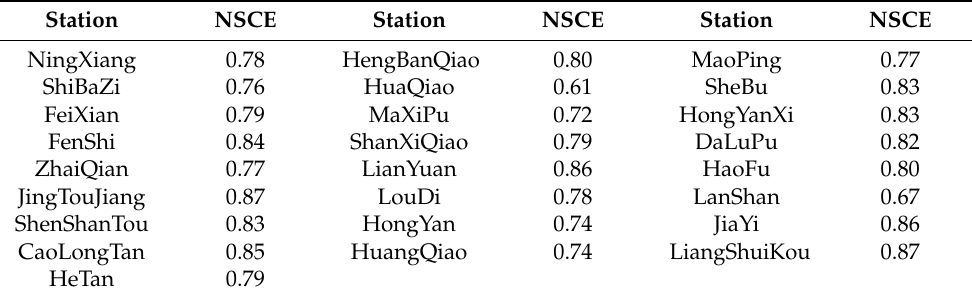
Table 4. Simulation results of calibration.